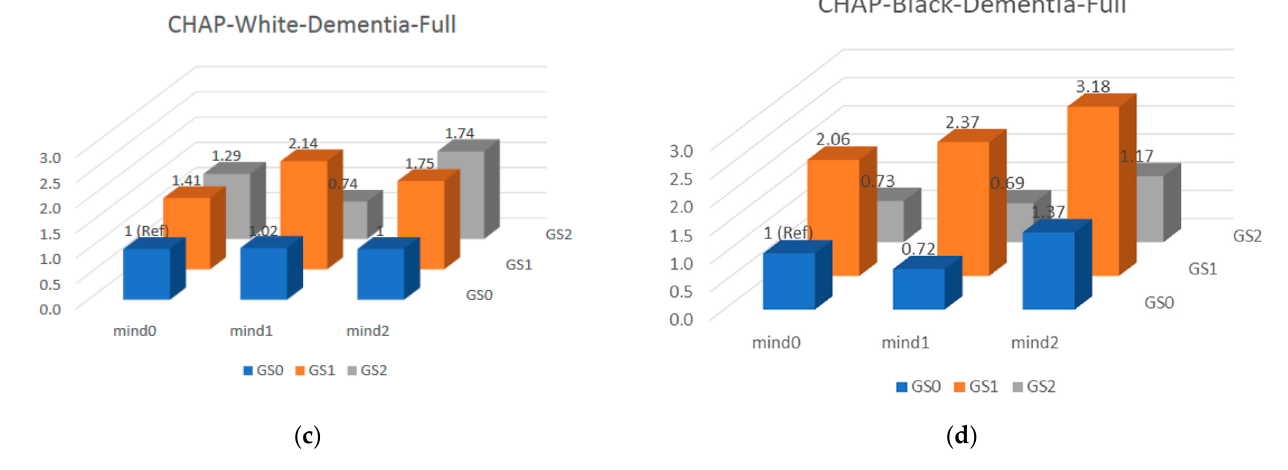
Figure 1. Joint analysis of GS AD × MIND and all-cause dementia. Results from Cox proportional hazard (HR, MAP ( a )/WHIMS ( b )) or logistic (OR, CHAP ( c , d )) regression models adjusted for age, sex (MAP, CHAP only), study center and randomization status (WHIMS only), education, income, global cognition score, late-life cognitive activity (MAP, CHAP only), history of diabetes, hypertension, stroke and heart disease; smoking, calorie intake, BMI, depressive symptoms, physical activity, genotype platform (MAP) or PCs (CHAP, WHIMS). Mind(GS)1, Mind(GS)2, Mind(GS)3 indicate tertile 1, tertile 2 and tertile 3 MIND adherence (GS) scores, respectively. Significant HR/ORs are bold-faced. Table 5. Gene × MIND Interaction Tests 1 .